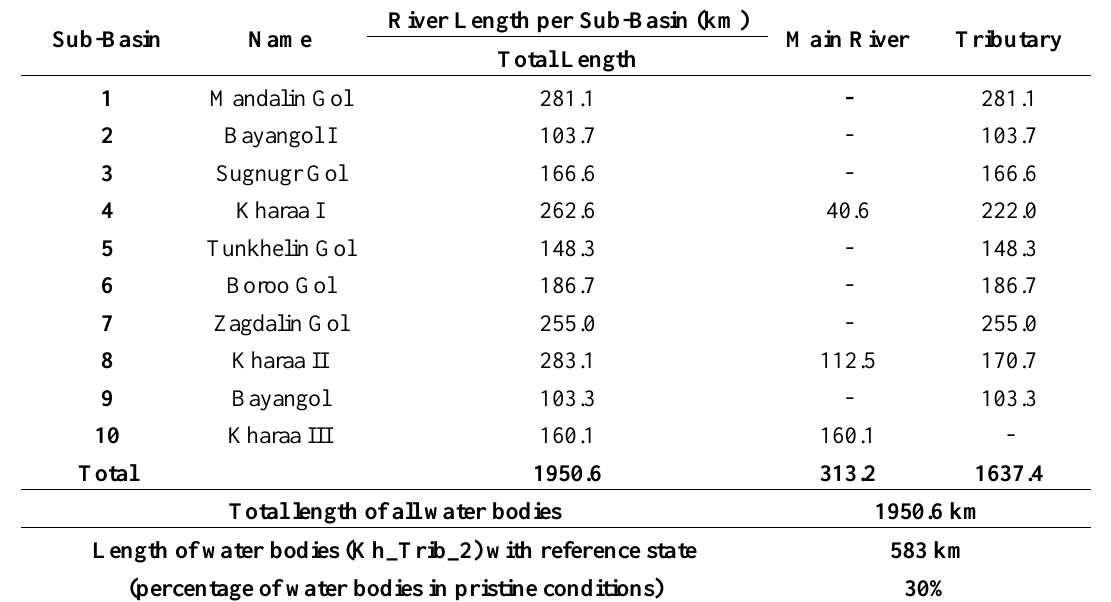
Table 6. Length of river network per subbasin (Figure